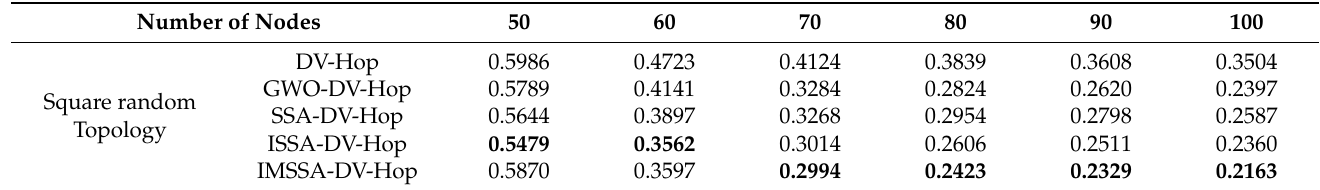
Table 4. Localization error in di ff erent number of nodes in square random topology. Table 5. Localization error in different number of nodes in C-shaped random topology.